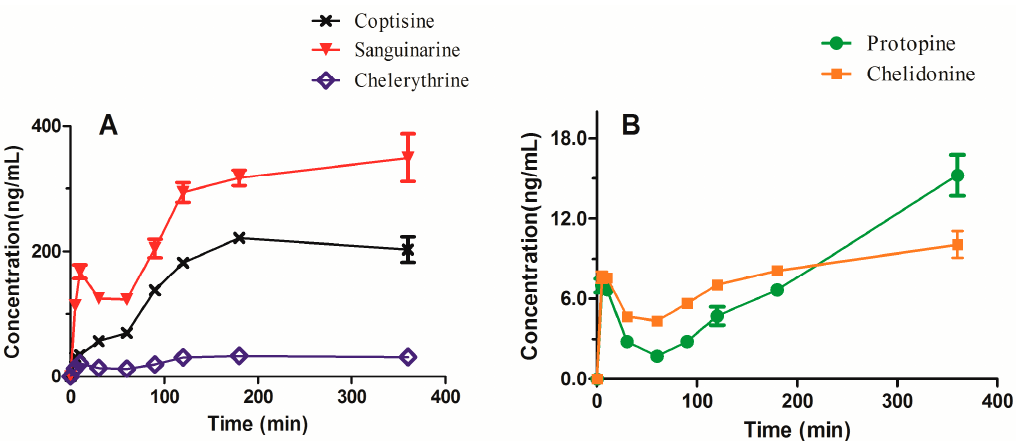
Figure 4. Intracellular concentrations of ( A ) coptisine, sanguinarine and chelerythrine, and ( B ) protopine and chelidonine after coincubation with Ch. majus extract.